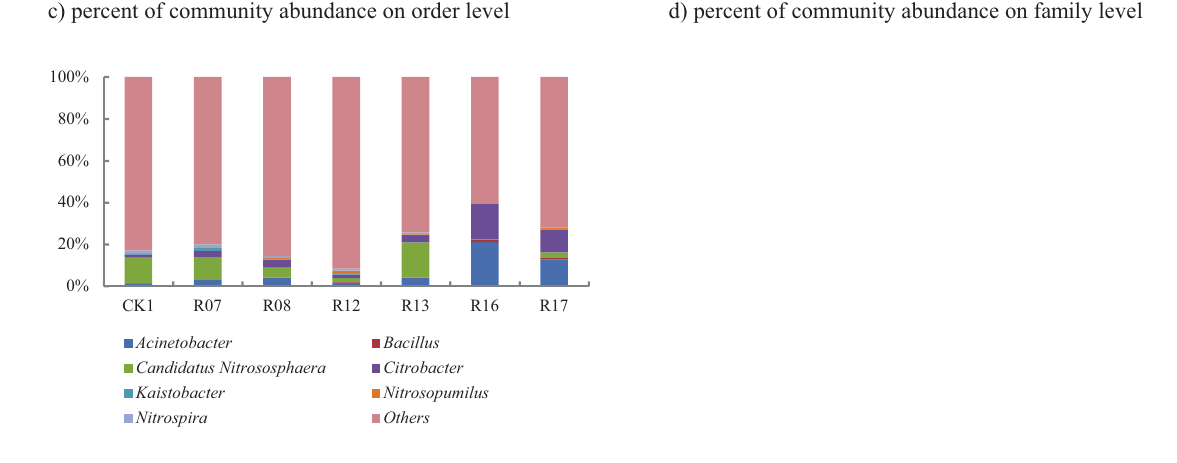
Figure 3. Relative abundance of staple microbial taxa on phyla/ class/ order/ family and genus across all samples. Phylogenetic groups with <1% relative abundance are classified as others